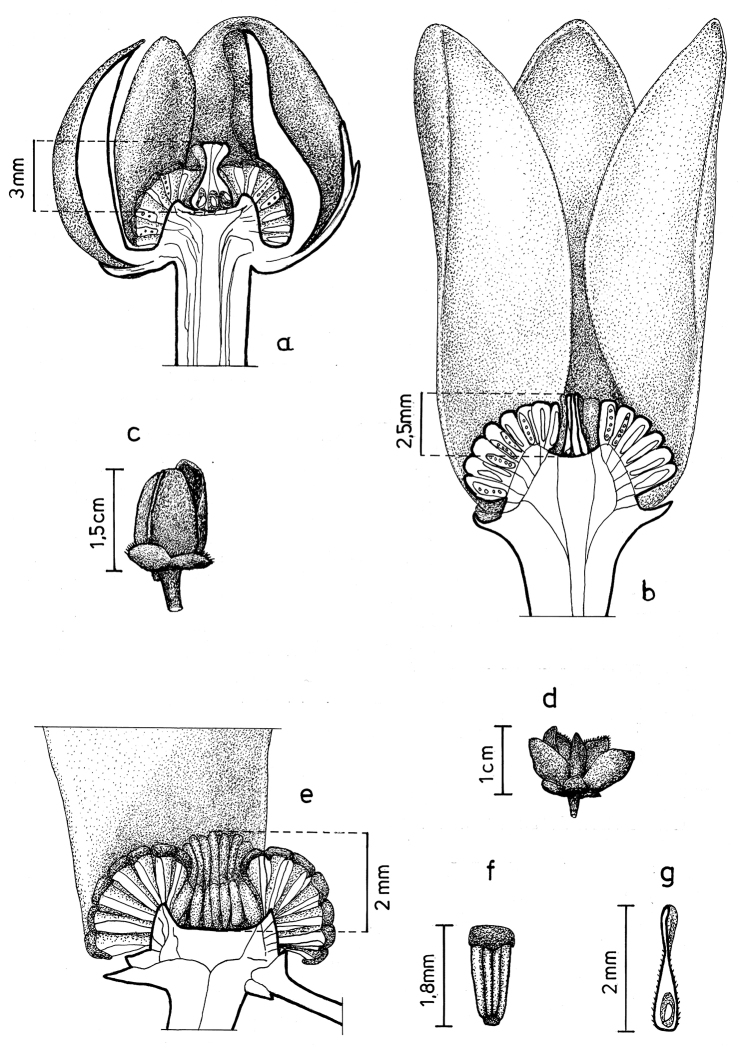
Flowers of Cremastosperma. Fig. 11 from van Heusden (1992). aC.microcarpum: longitudinal section bC.oblongum R.E.Fr.: longitudinal section cC.monospermum (Rusby) R.E.Fr.: bud dC.gracilipes R.E.Fr.: flower e, fC.cauliflorum R.E.Fr.: longitudinal section (e) and stamen (f) gC.microcarpum: carpel (aMaas et al. 6281bMaas et al. 4592cNelson 763dLuteyn et al. 4890e, fHolm-Nielsen et al. 21501gPrance et al. 3527).